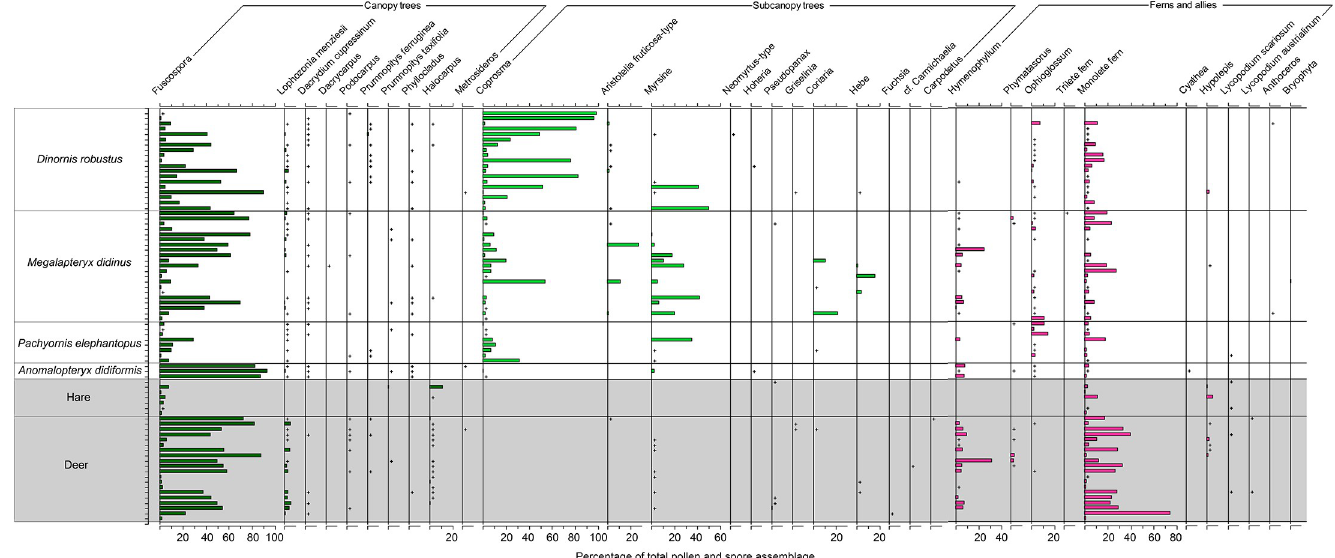
Fig 5. Pollen diagram showing tree pollen and fern spores. Moa coprolites and mammal pellets from Daley’s Flat rock avalanche deposit. Rare pollen types ( < 1% total pollen assemblage) are represented by + symbols.